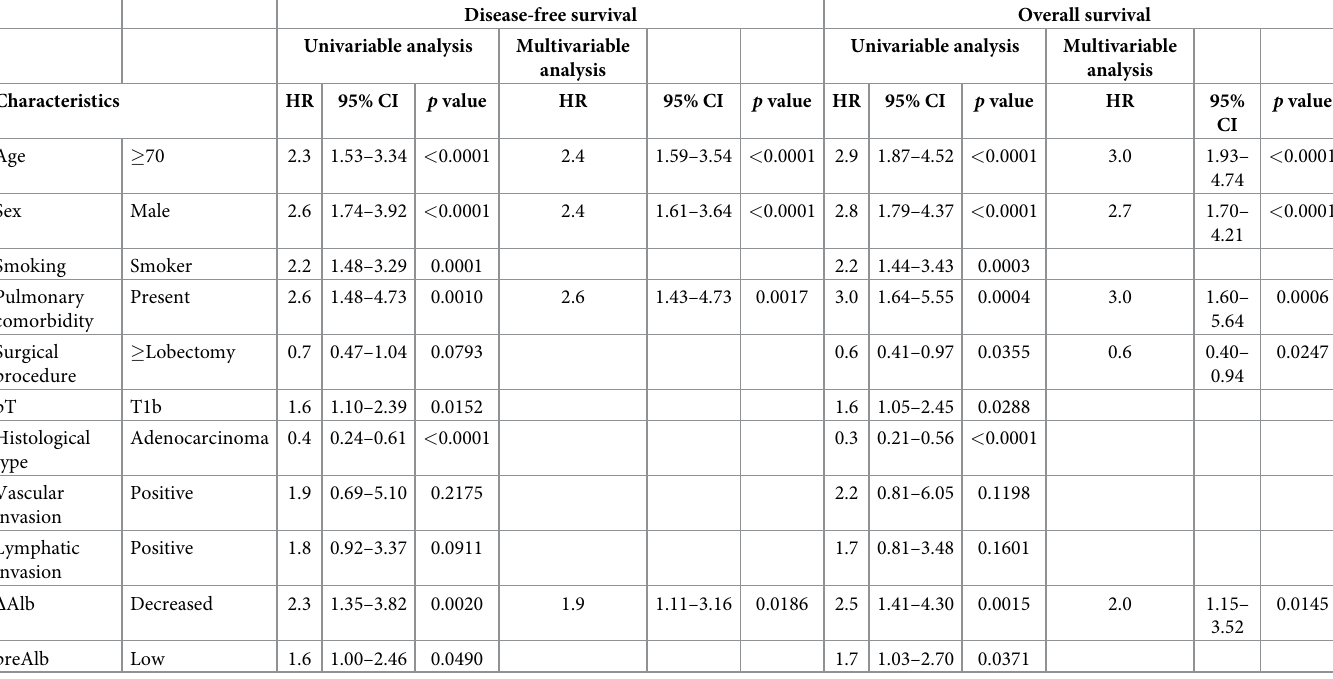
Table 2. Univariable and multivariable analyses of disease-free survival and overall survival in the validation